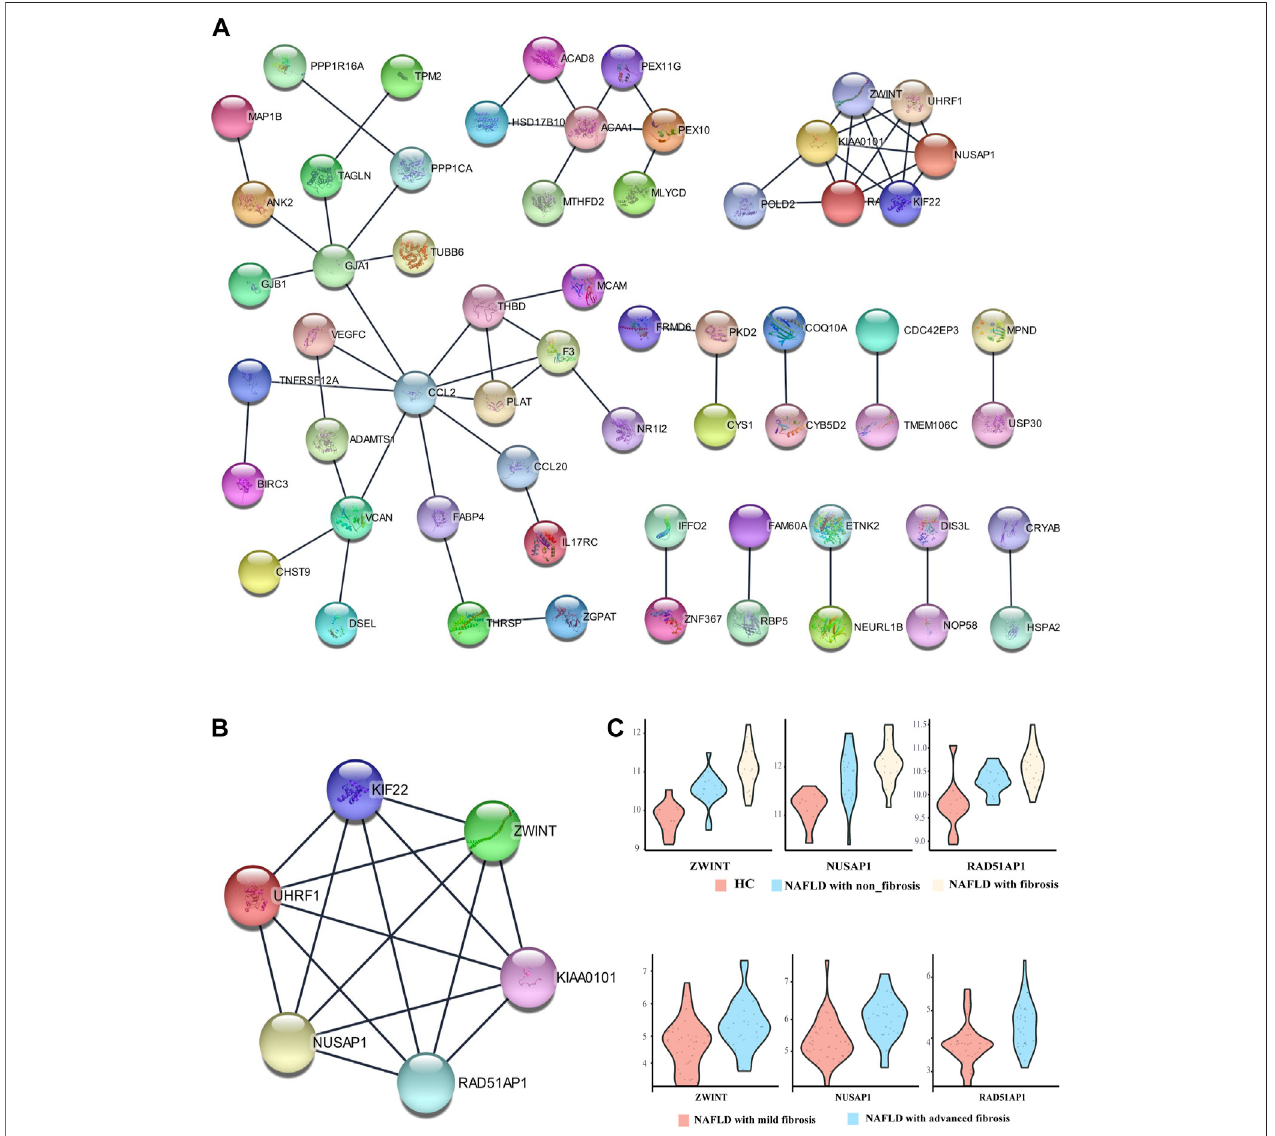
FIGURE 4 | Protein-protein interaction (PPI) network. (A) PPI network of differentially expressed genes (DEGs), (B) subnetwork of top-six hub genes from the PPI network, (C) The expression pattern of ZWINT, NUSAP1 and RAD51AP1 in the different stage of NAFLD.